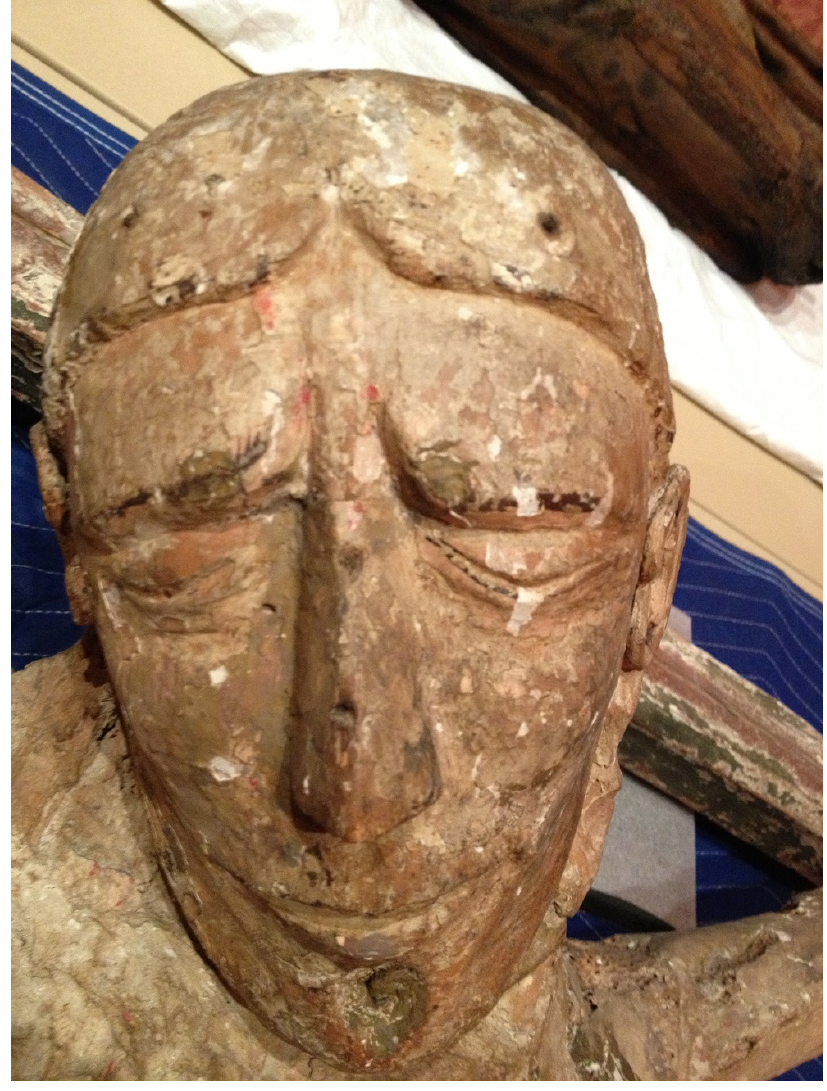
Figure A4. Crucifix, unknown Spanish, early 13th century, detail of face. Source : 52.34 Memorial Art Gallery of the University of Rochester. (Photograph taken by the author).